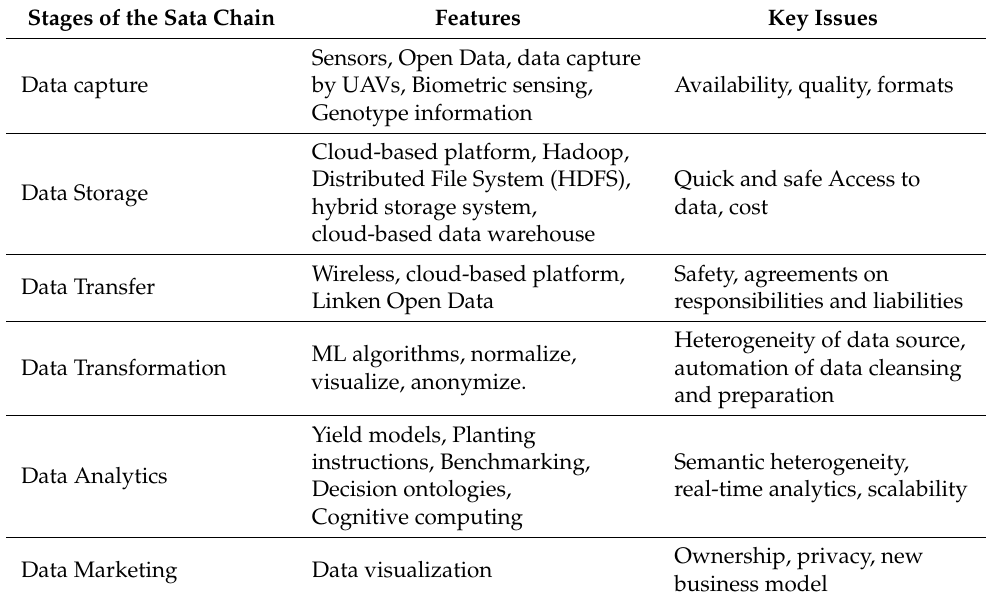
Table 3. Features of Big Data applications in Smart Farming and key issues [9]. Stages of the Sata